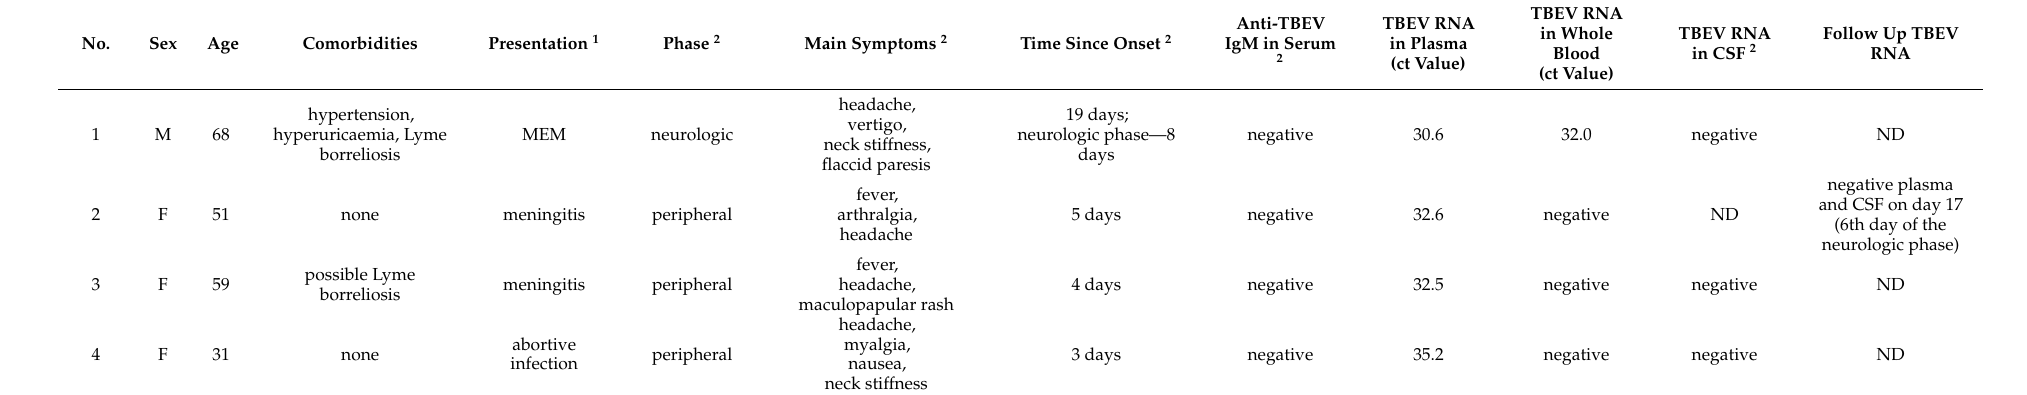
Table 2. The basic clinical and laboratory parameters of patients with positive results of a plasma rtPCR test for TBEV